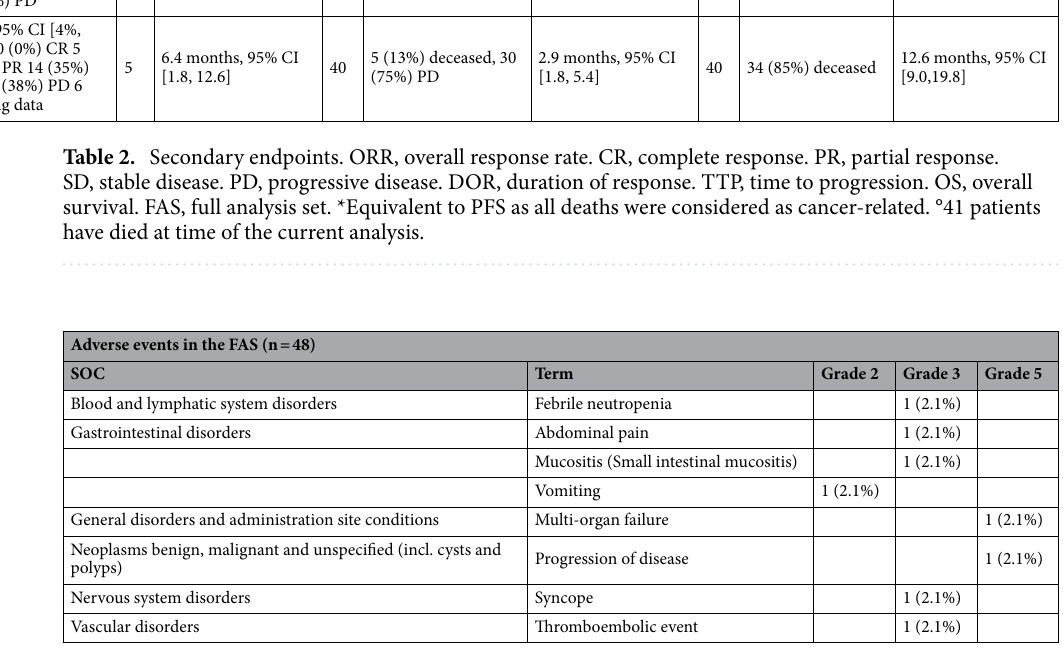
Table 3. Serious adverse events. Serious adverse events, highest grade as experienced by trial